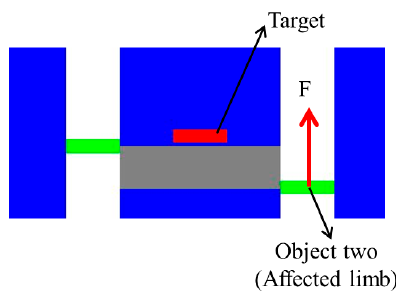
Figure 7. Upward feedback provided by the haptic